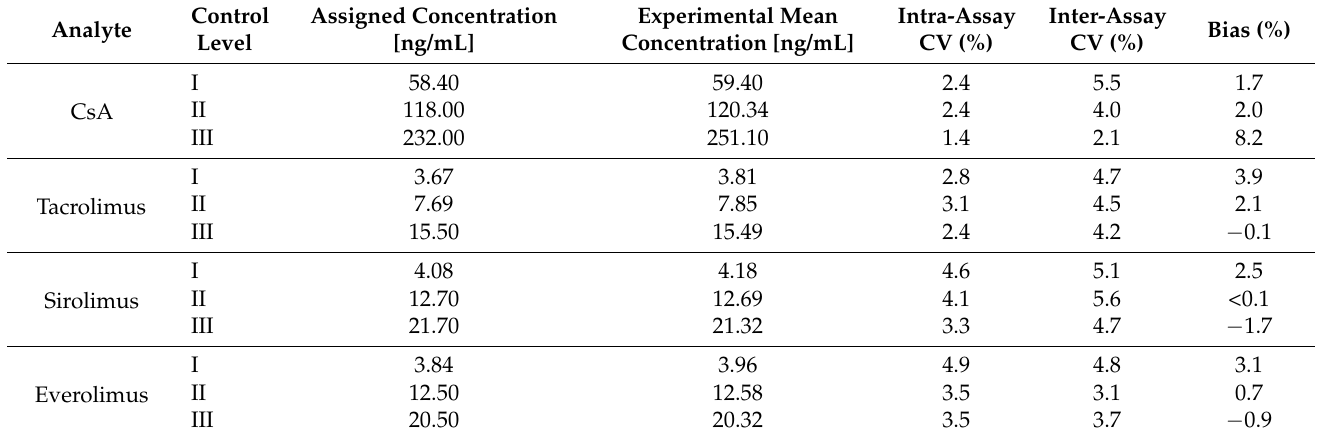
Table 4. Intra- and inter-assay precision and accuracy (given as bias %) regarding Shimadzu–Recipe analysis are shown for each control level (I–III).